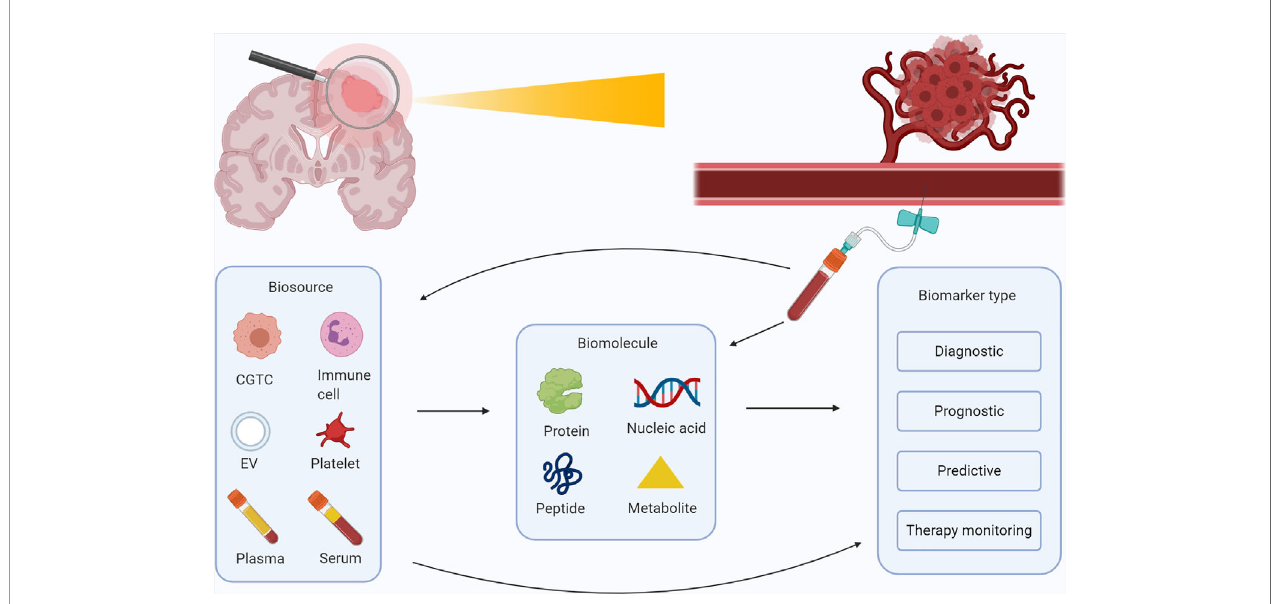
FIGURE 2 | Overview of possible blood-based biomarkers for glioma and their purposes. Schematic overview of the several biosources (plasma, serum, extracellular vesicles, blood platelets, circulating immune cells, and circulating glioma tumor cells) and biomolecules (proteins, nucleic acids, metabolomics and peptides) that are identi fi ed for patients with glioma. These biomolecules can be collected in a vial of blood, and employed as a diagnostic, prognostic, predictive, or therapy monitoring marker. Figure was created with